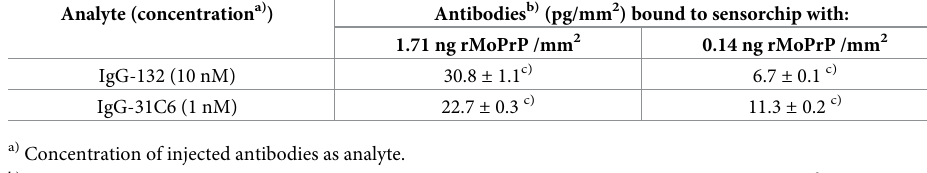
Table 2. Antigen density-dependent binding of mAb